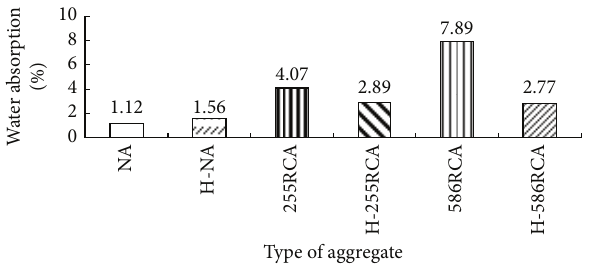
Figure 2: Water absorption of various types of aggregates.